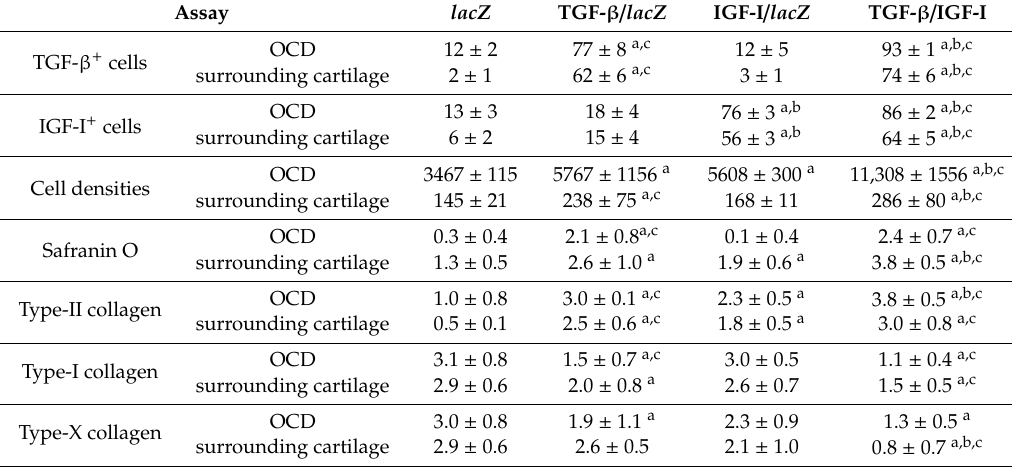
Table 2. Histomorphometric analyses in human osteochondral defects OCDs following implantation of rAAV-transduced hMSC aggregates (day 21). TGF- β -positive (TGF- β + ) and IGF-positive (IGF-I + ) cells are in %. The cell densities are as cells / mm 2 . Stained (safranin O) and immunostained (type-II, -I, and -X collagen) sections were scored for uniformity and intensity according to modified Bern Score grading system [19] as: 0 (no staining), 1 (heterogenous and / or weak staining), 2 (homogeneous and / or moderate staining), 3 (homogeneous and / or intense staining) and 4 (very intense staining). Data are given as mean ± SD. Statistically significant relative to a lacZ , b TGF- β / lac Z, and c IGF-I / lac Z.